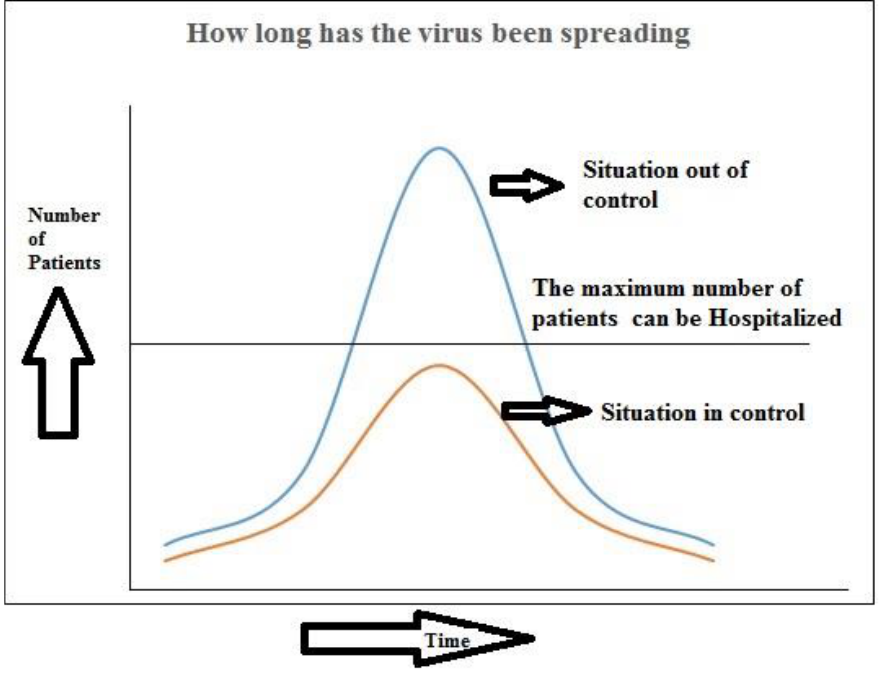
Figure 5. Graph showing the number of patients against the time with consideration of two